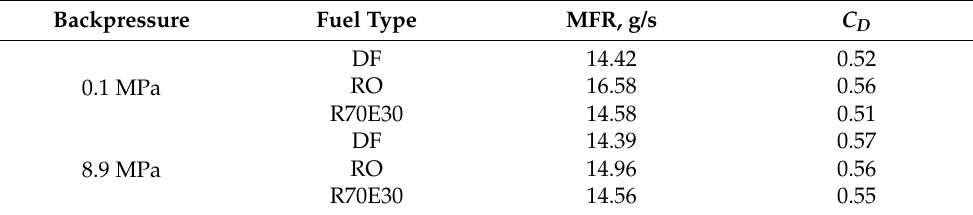
Table 8. Calculated MFR and C D for DF, RO, and